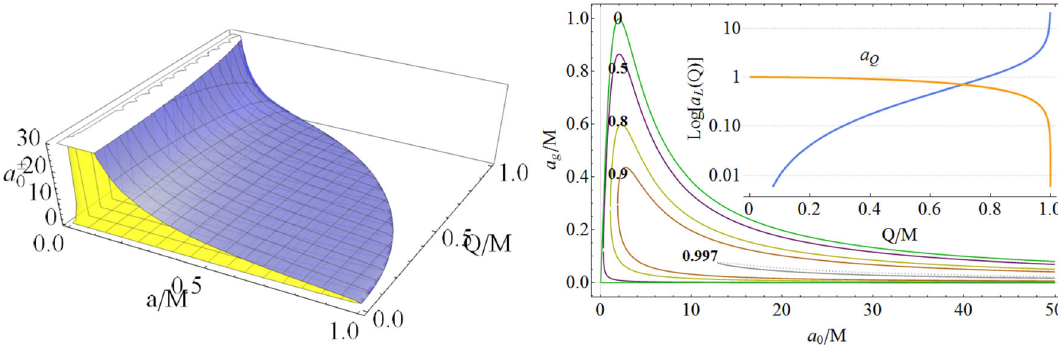
(cid:6) M 2 − Q 2 , a g is defined for Q ∈] 0 , M [ and a L ( Q ) , where a Q ≡ a g ≥ a L ( Q ) – see Eq. (38). BH Killing horizons are defined by the condition a ≤ a Q (for a >